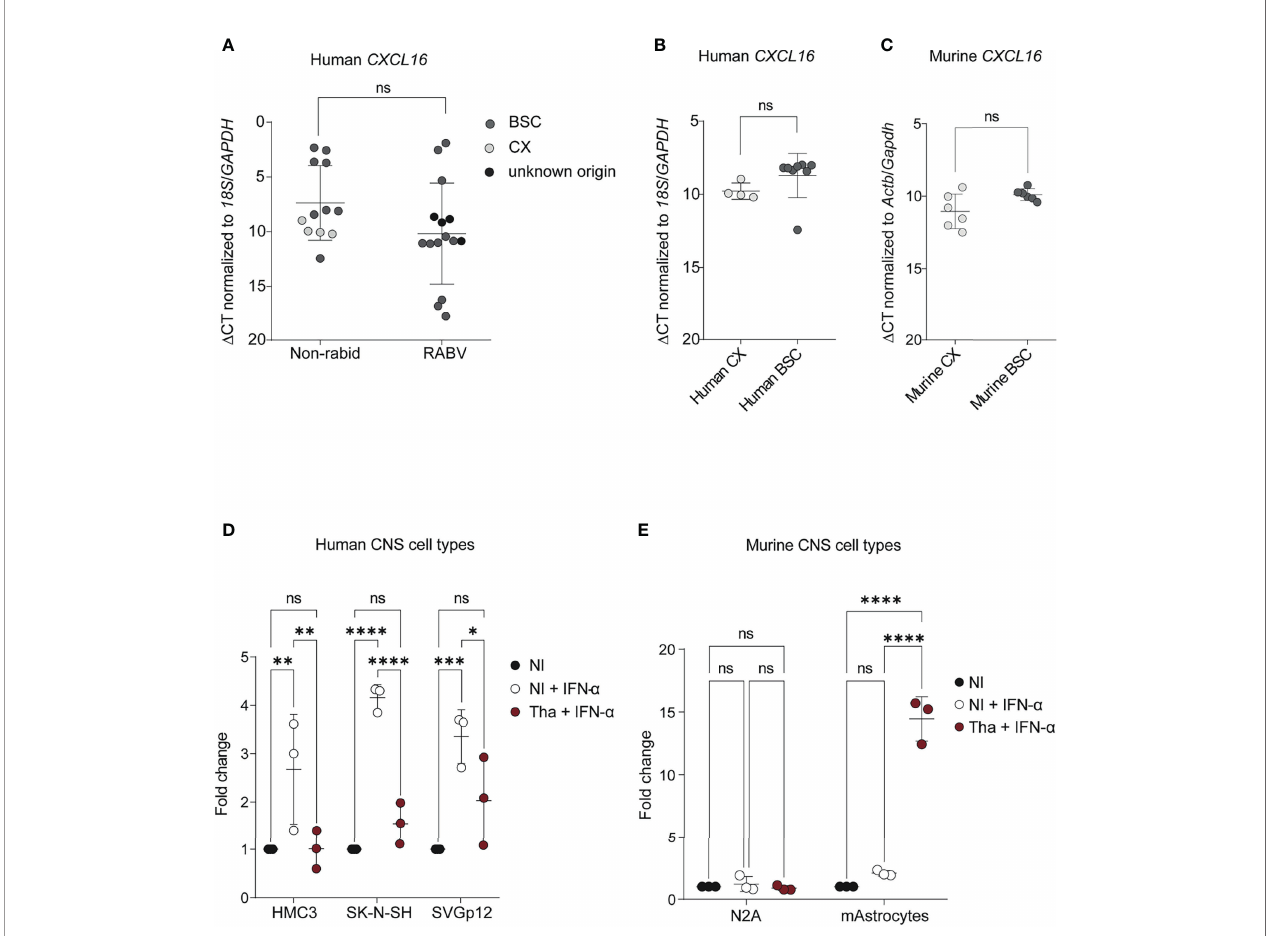
FIGURE 4 | CXCL16 gene expression in human and murine brains and CNS cell types during RABV infection. (A) CXCL16 gene expression in brain from non-rabid patients and rabid patients (from group 1 and 2). Comparison of CXCL16 expression in brains from non-rabid (control) patients (n = 12; 12 samples) from Cambodia (IPC38, IPC39, IPC40, IPC41, IPC42) and France (P448, P447, P465, P521, P552, P523, P524) and from rabid patients (n=12; 15 samples) from Cambodia (IPC02, IPC08, IPC12, IPC15, IPC18, IPC23, IPC24, IPC28, IPC34, IPC36), Senegal (IPS01), Moldavia (1900105, 1900106, 1900107), and Madagascar (IPM01). A detailed overview of the additional included human samples can be found in Supplementary Table S5 . CXCL16 expression values ( D CT) were compared by using an unpaired t-test. (B) CXCL16 expression in non-infected control human CX (n=4) and BSC (n=8) samples. CXCL16 expression values ( D CT) between CX (P447, P465, P523, P524) and BSC (IPC38, IPC39, IPC40, IPC41, IPC42, P448, P521, P552) were compared by using an unpaired t-test (p=0.072). (C) Cxcl16 expression in the CX (n=6) and BSC (n=6) of non-infected mice. Cxcl16 expression values ( D CT) between CX and BSC were compared by using a paired t-test (p=0.122). (D) CXCL16 expression in human CNS cell types (n = 3) infected with RABV Tha (48 hours post-infection). Human CNS cell types (SK-N-SH, HMC3, SVGp12) were infected with Tha (MOI 5) and treated with IFN- a at 24 hours post-infection. (E) Cxcl16 expression in murine neuroblastoma cells and cortical murine astrocytes (n=3) upon RABV Tha strain infection (48 hours post-infection). Murine CNS cell types were infected with Tha (MOI 5) and treated with IFN- a at 24 hours post-infection. Murine astrocytes were extracted from C57BL/6 wild type mice and their phenotype was validated by immuno fl uorescence and qPCR (Supplementary Figure S8) . (D, E) All cell culture experiments were performed in three independently replicates. Bars show average fold changed ± SD with a Tukey ’ s multiple comparison test (adjusted p-value ****< 0.0001, ***< 0.001, **< 0.01, *< 0.05). BSC, brainstem/cerebellum; CX, cortex; HMC3, human microglial cell line; mAstrocytes, cortical murine astrocytes; NI, non-infected; N2A, murine neuroblastoma cells; SK-N-SH, human neuroblastoma cell line; SVGp12, human astroglia cell line; ns, non-signi fi